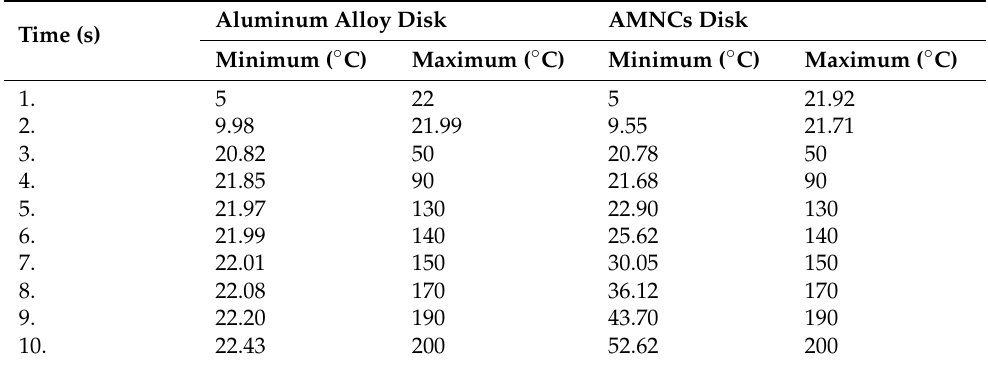
Table 3. Temperature distribution in aluminum alloy and AMNCs ventilated disc. Time